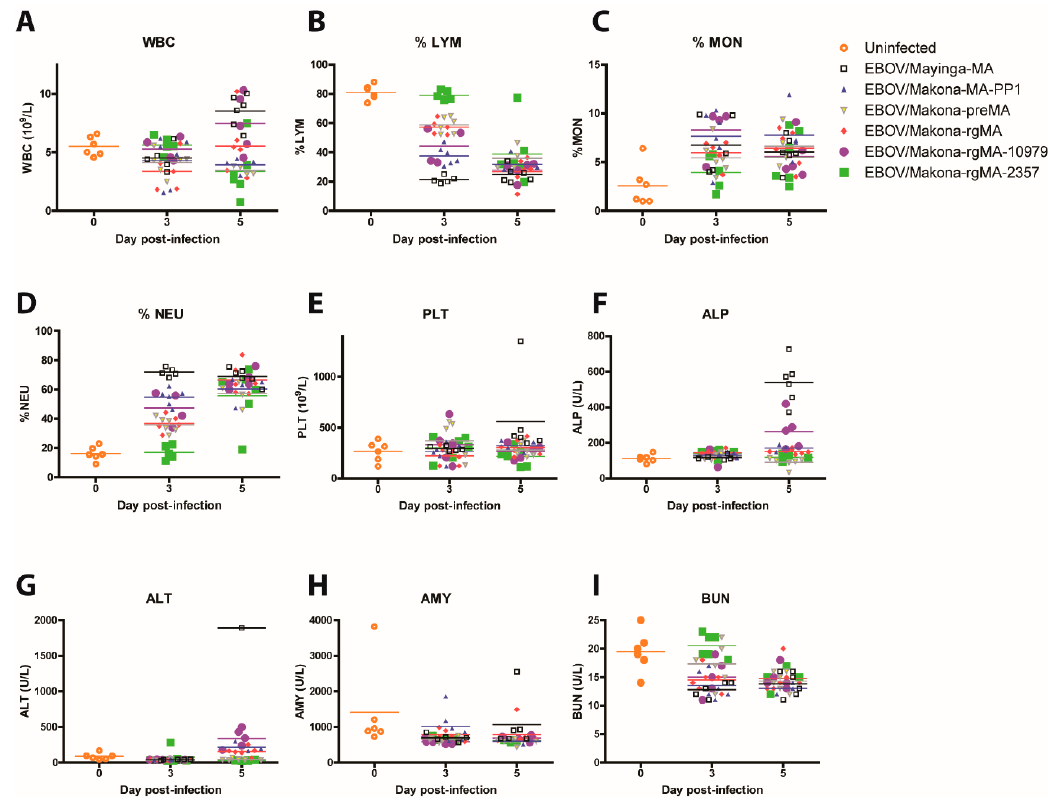
Figure 3. Hematology and blood biochemistry in mice who were infected with MA-EBOV. Groups of mice ( n = 6) were infected intraperitoneally with 10 PFU of either EBOV/Mayinga-MA, EBOV/Makona-MA-PP1, EBOV/Makona-preMA, EBOV/Makona-rgMA, or the two single mutant viruses EBOV/Makona-rgMA-10979 or EBOV/Makona-rgMA-2357. Blood samples were collected on days 3 and 5 post-infection and ( A ) total white blood cell count (WBC), ( B ) % lymphocytes (%LYM), ( C ) % monocytes (%MON), ( D ) % neutrophils (%NEU), ( E ) platelets (PLT), ( F ) alkaline phosphatase (ALP), ( G ) alanine aminotransferase (ALT), ( H ) amylase (AMY), and ( I ) blood urea nitrogen (BUN) were measured. Blood was also collected on day 0 from a group of uninfected BALB/c mice ( n = 6) to establish baseline levels for all the parameters.